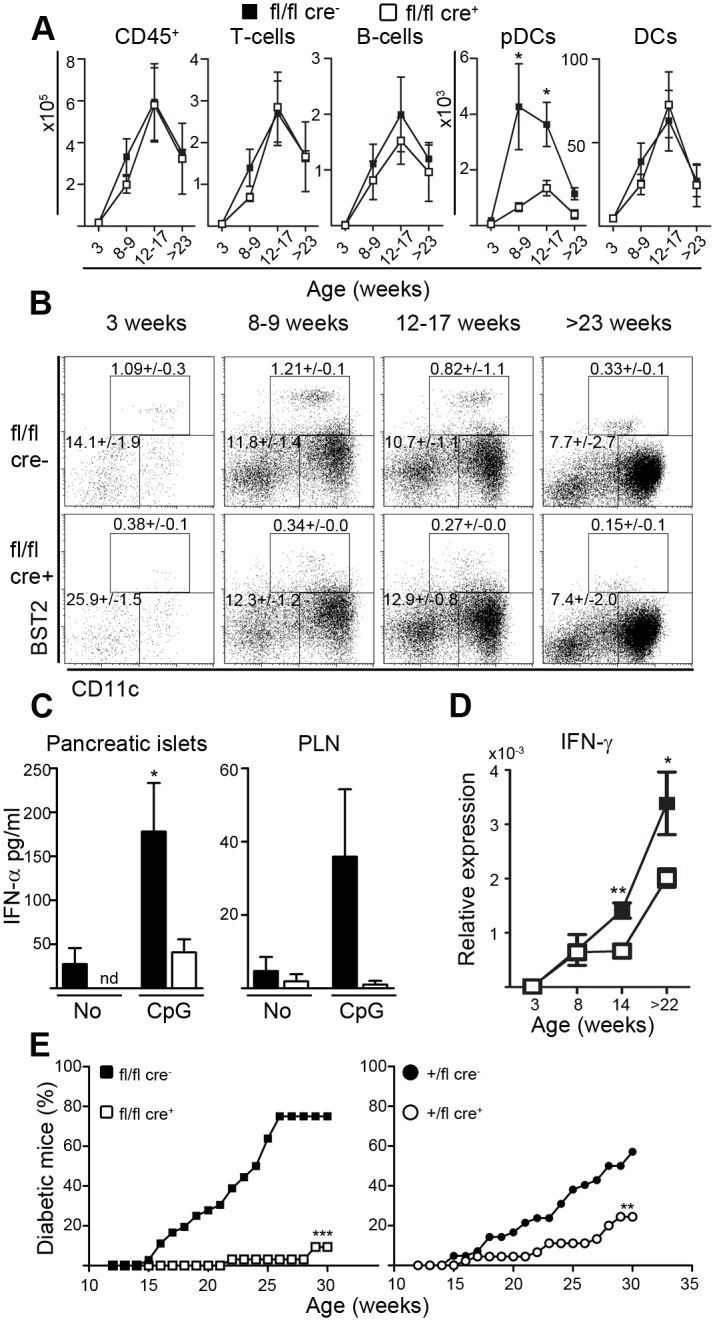
Impaired recruitment of pDCs to pancreatic islets alters cytokine profile of insulitis and prevents diabetes development.(A) Flow cytometry analysis of leukocytes (FVD−CD45+) from handpicked pancreatic islets of fl/fl cre− (black square) or fl/fl cre+ (open square) mice at indicated age. Cell types include pDCs (CD3−CD19−BST2+CD11cintB220+), inflammatory DCs (CD3−CD19−BST2−CD11chiMHC-II+), B-cells (CD3− B220+CD19+), T-cells (CD3+B220−CD19−). Number of cells per mouse (mean ± sem, n = 5–15 mice, 2–5 independent experiments). * p<0.05. (B) Representative dot plots of FVD−CD45+CD3−CD19− islet cells with the percentage of pDC and inflammatory DC subsets of total CD45+ cells indicated (mean ± sem, n = 5–15 mice, 2–5 independent experiments) (C) IFN-α levels in supernatants from cultured fl/fl cre− (black bars) or fl/fl cre+ (open bars) islets or cultured single cell suspensions from PaLN at 8–17 weeks of age after 40h or 24h, respectively ± TLR9 ligand CpG1585 is assessed by ELISA (mean ± sem, n = 22–24 mice, 5–6 independent experiments for islets and n = 13–14 mice, 4–5 independent experiments for PaLN). nd = not detected. * p<0.05. (D) Expression of IFN-γ is assessed by qPCR of RNA from handpicked islets of fl/fl cre− (black square) and fl/fl cre+ (open square) mice at 3->22 weeks of age (mean ± sem, n = 3–9 mice, 3 independent experiments). ** p<0.005, * p<0.05 (E) Incidence of diabetes in fl/fl cre− (black square) and fl/fl cre+ (open square) (n = 36–32). *** p<0.0001. Incidence of diabetes in +/fl cre+ (black circle) and +/fl cre− (open circle) (n = 45–42). ** p = 0.0014.